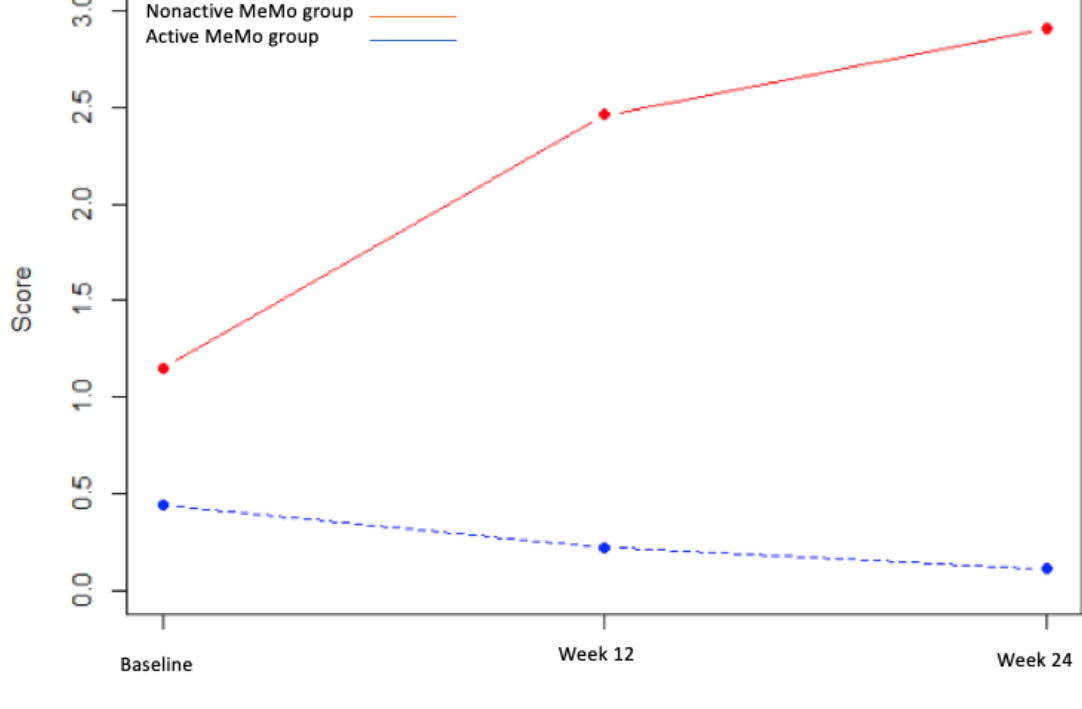
Table 3. Maximum performance score observed for each game in the MeMo app at the end of the study after 12 weeks of use.